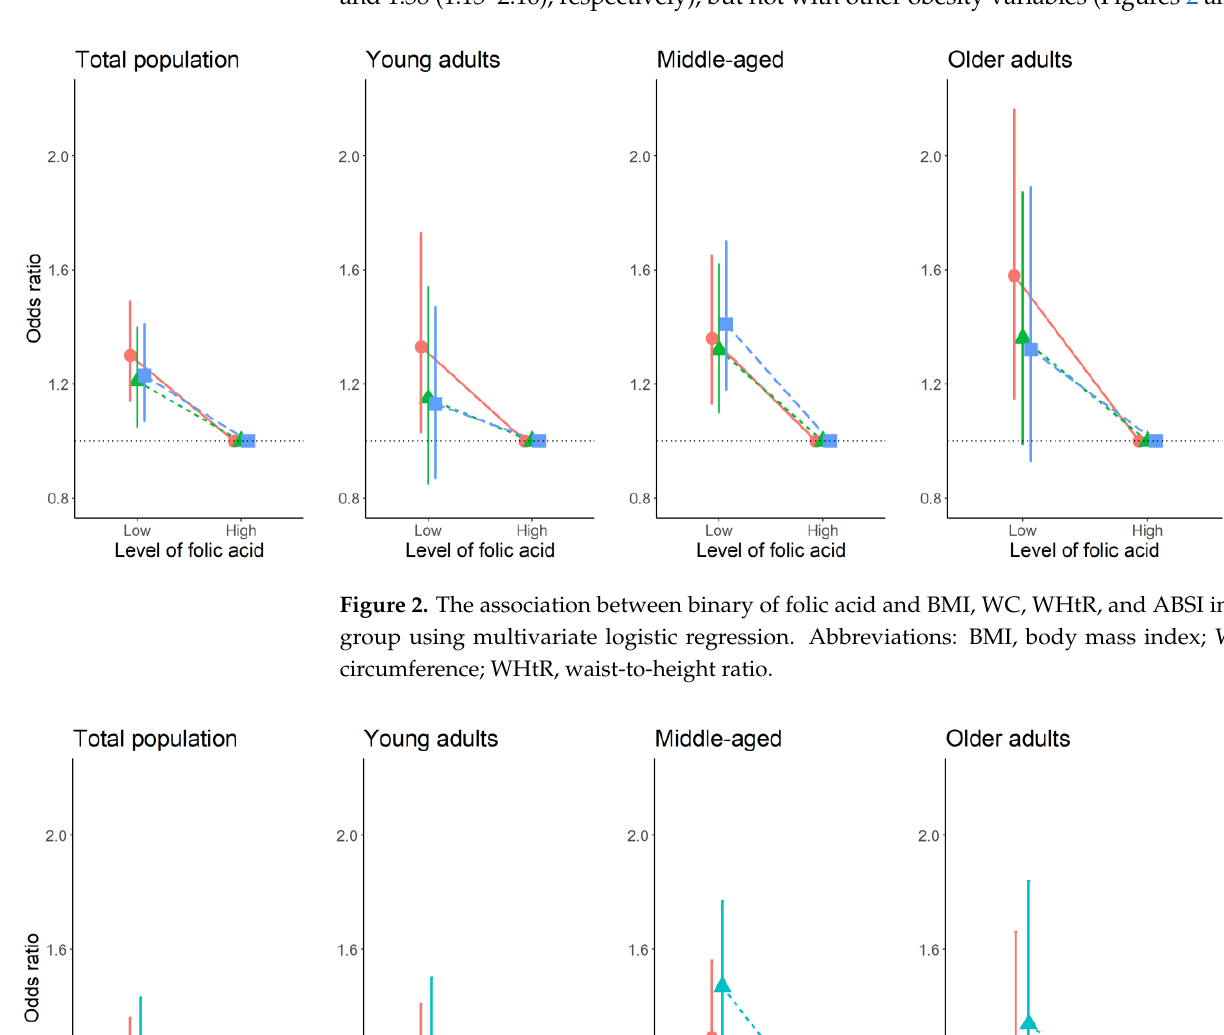
Figure 4. The association between the binary of folic acid and high – sensitivity C-reactive protein in each age group using multivariate logistic regression. Abbreviations: hs-CRP, high-sensitivity C-reactive protein. 4. Discussion This study examined the association of serum folate levels with all five measures of obesity (BMI, WC, WHtR, ABSI, and BRI) and hs-CRP levels in a nationally representa- tive sample of Korean adults, especially middle-aged adults. However, in young adults and older adults, only obesity measured by BMI was statistically significant. In this study, the level of folic acid increased with age, which is similar to the results of previous studies that used representative US data [26]. Our findings are similar to those of a previous study. A study of 2695 Brazilian subjects showed that dietary folate intake was negatively associated with overweight (BMI ≥ 25 kg/m 2 ) and obese (BMI ≥ 30 kg/m 2 ) prevalence [27].